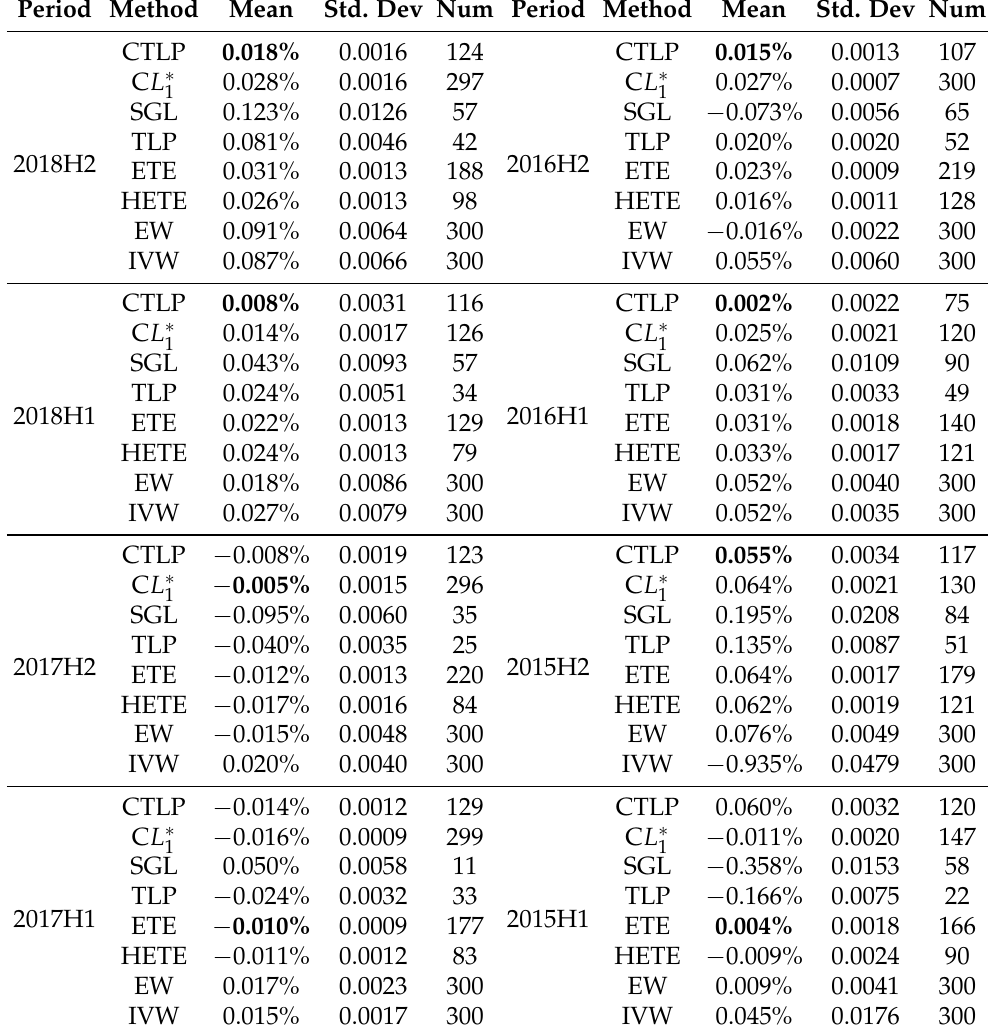
Table 8. The performance of the selected portfolio. By different methods in eight periods. Mean, Std. Dev and Num stand for the mean, the standard deviation of tracking error and the number of stocks in the portfolio. In the columns of period, for example, 2018H1 stands for the first half year of